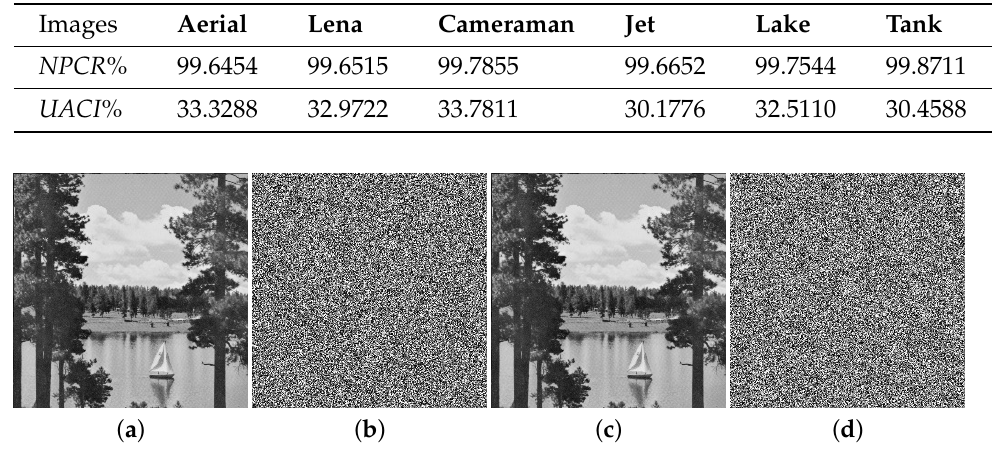
Figure 14. Plain image sensitivity: ( a ) lake; ( b ) encrypted lake; ( c ) lake SSIM = 0.9989; ( d ) en- crypted lake.